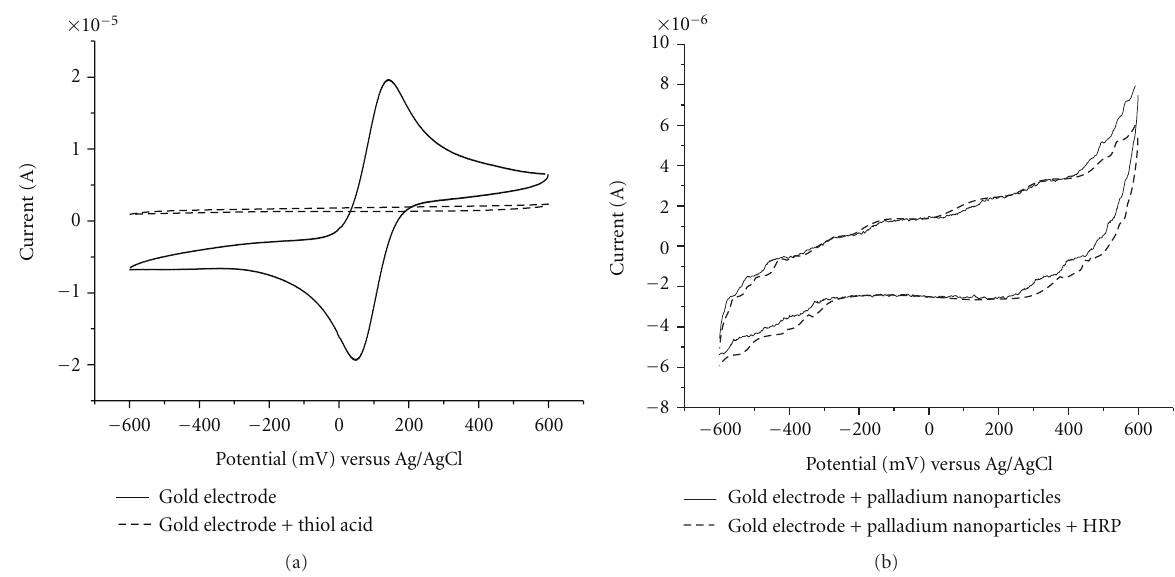
Figure 1: (a) Cyclic voltammogram of gold electrode and gold electrode with thiol acid. (b) Cyclic voltammogram of gold electrode with palladium nanoparticles and gold electrode with palladium nanoparticles with HRP.